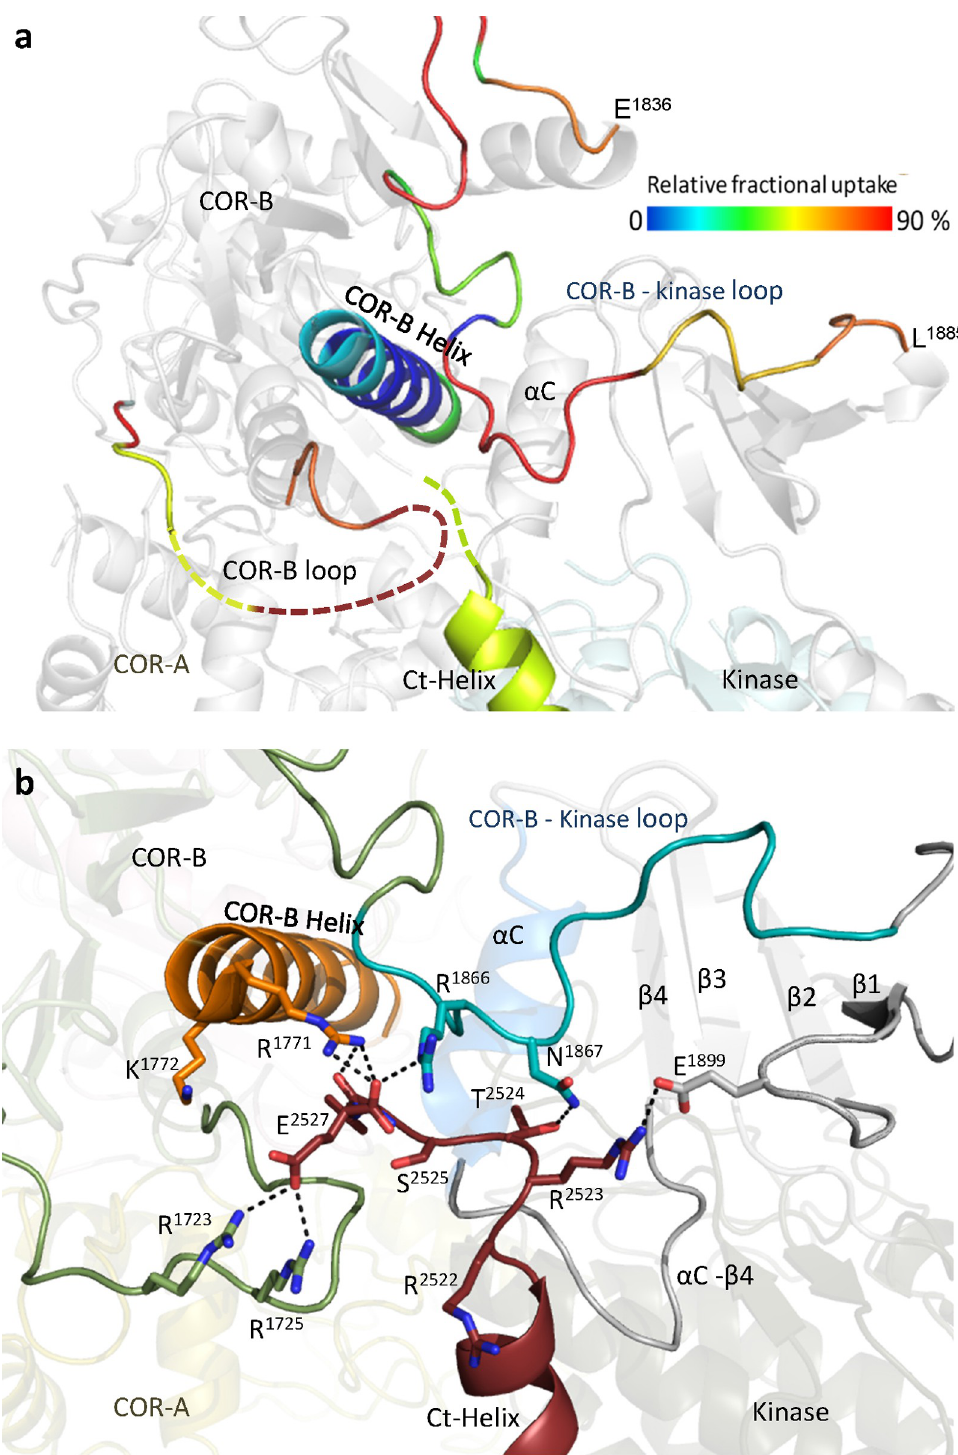
Fig 6. Capping of the N-lobe of the kinase domain. (a) In the LRRK2 RCKW cryo-EM structure, the linker from COR-B to the kinase domain lies over the N-lobe of the kinase domain. Nearby is a disordered loop from COR-B and the disordered 3 terminal residues (PDB: 6VNO). The AU : PleasecheckandconfirmthattheedittothesentenceTheloops ; COR (cid:0) BHelix ; andtheCt (cid:0) Helixare ::: didnotaltertheintendedthoughtofthesentence : loops, COR-B Helix, and the Ct-Helix are colored based on the relative fractional uptake. (b) MD simulations capture potential interactions between the C-terminal residues, the COR-B-kinase loop, and basic residues at the N-terminus of the COR-B Helix. cryo-EM, cryogenic electron microscopy; Ct-Helix, C- terminal helix; MD, molecular dynamics.